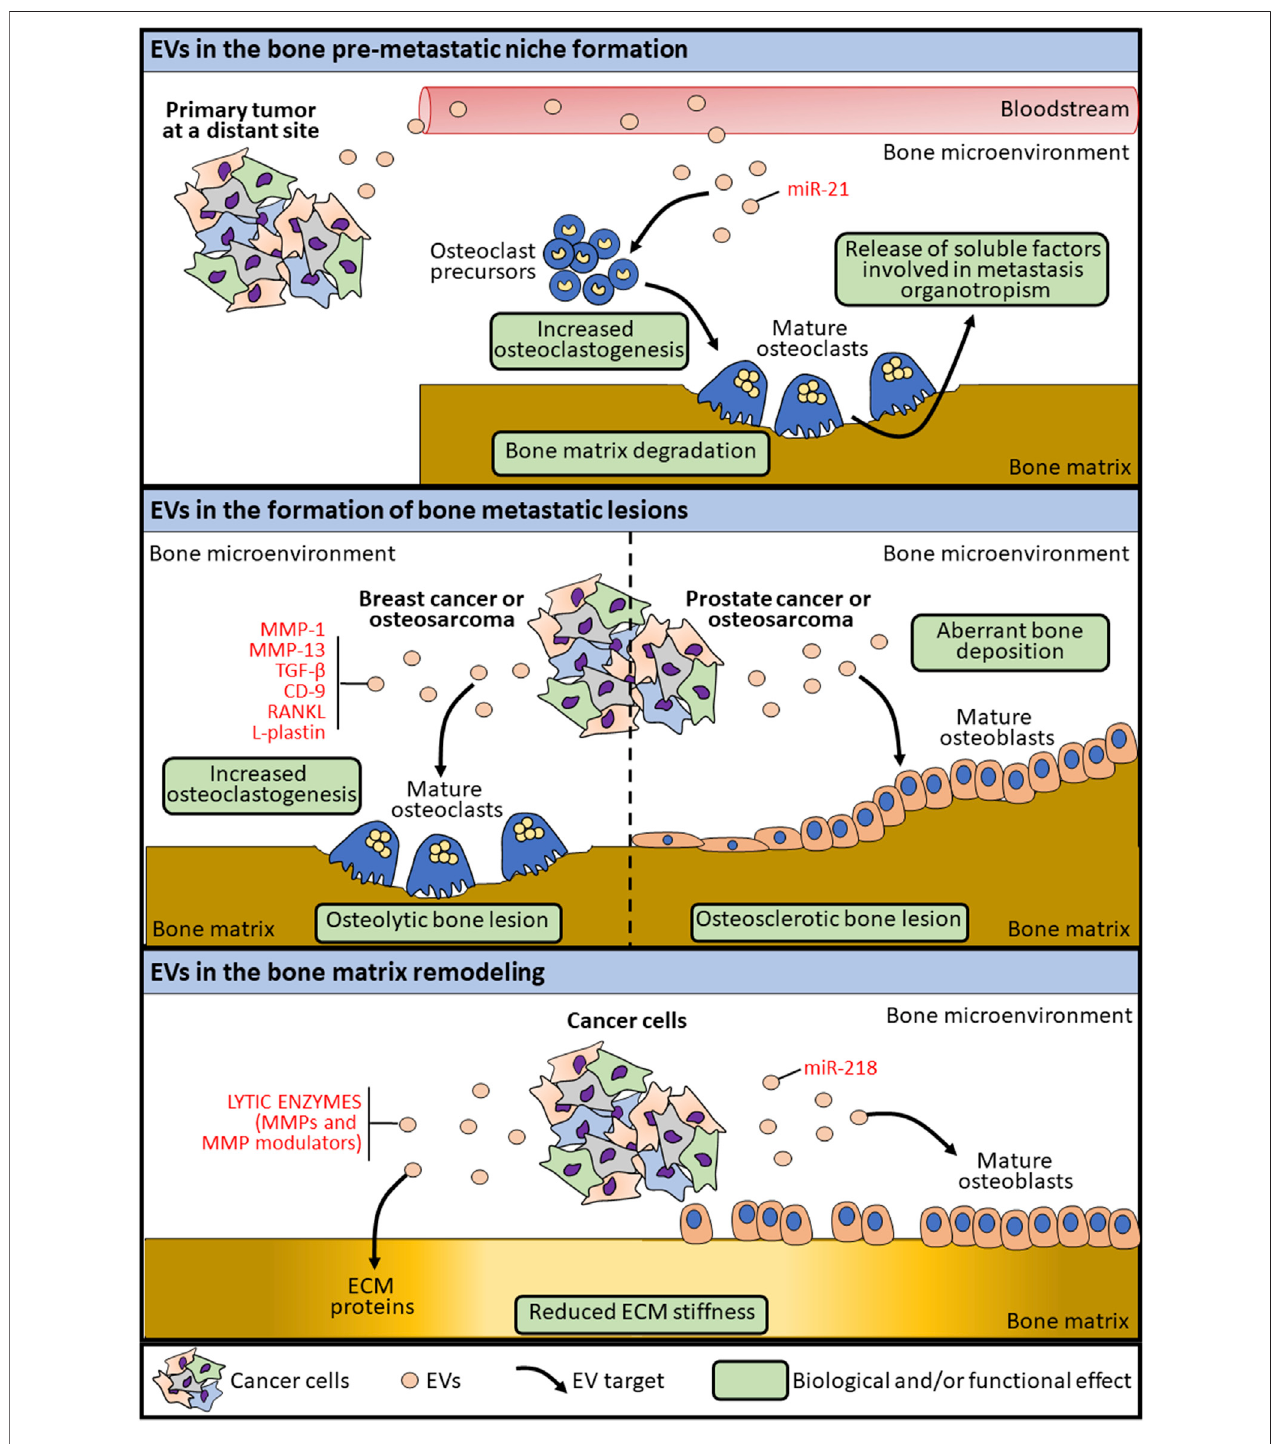
FIGURE 1 | Schematic representation of the mechanisms by which EVs are involved in bone lesion formation.